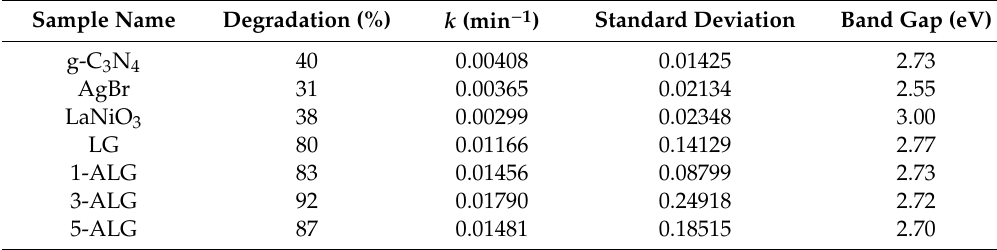
Figure 9. Photocatalytic performances ( a ) and the corresponding kinetic curves analyzed by the pseudo-first-order kinetic model ( b ) for NOR degradation over different photocatalysts. Table 3. Photocatalytic results and crystalline size of all the samples.